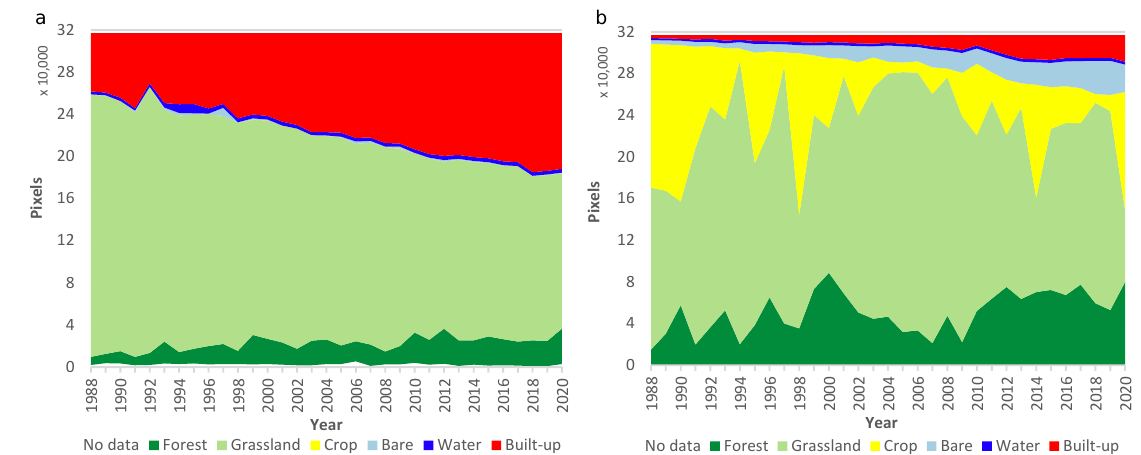
Figure 12. Distribution of land cover classes for 1988–2020 for simplified U-Net CNN model ( a ); and simplified DEA Land Cover ( b ) for Gungahlin area in Figure 11.